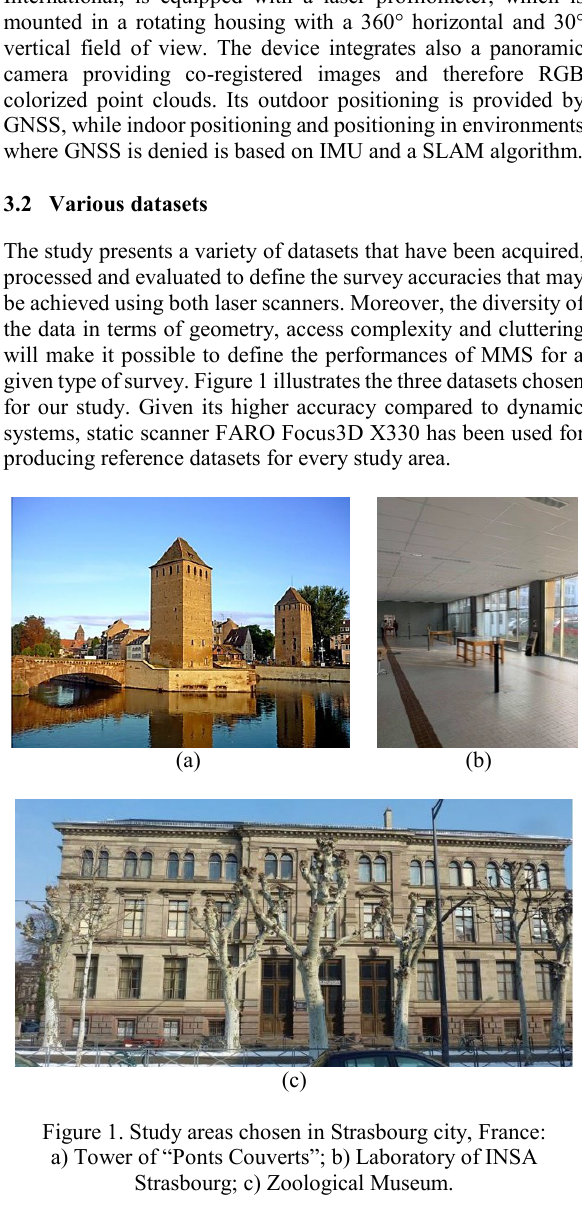
Table 1: Features of the studied systems